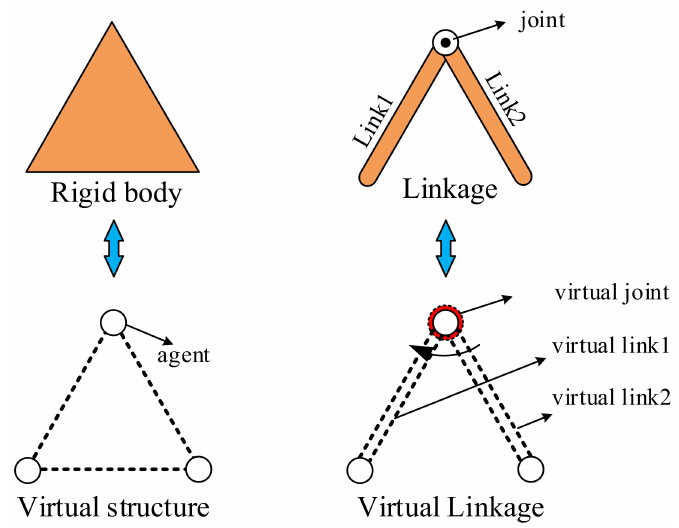
Figure 2. Principle of virtual structure and virtual